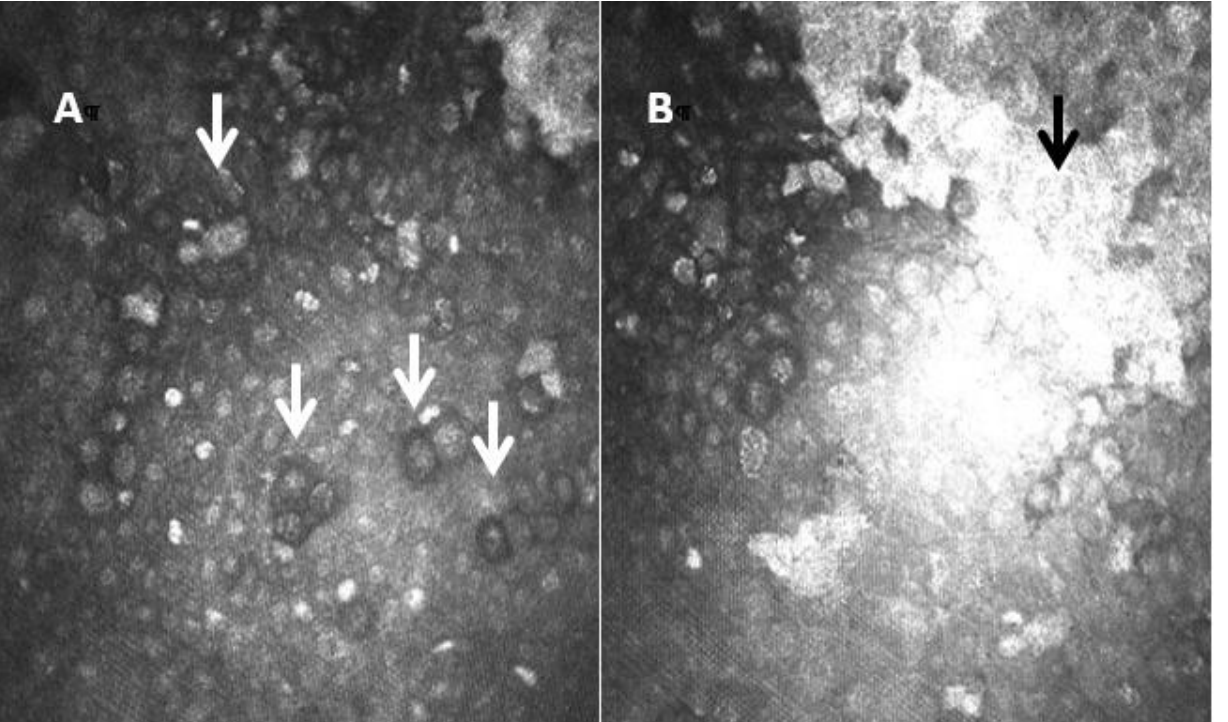
Figure 6. Laser confocal microscopic images of Acanthamoeba cysts. In image ( A ), the cysts show a highly reflective nucleus surrounded by a low-refractile ring wall (white arrows). The central structure is regular and round with uniform reflection. In image ( B ) we also see a hyperreflective scar (black arrow).